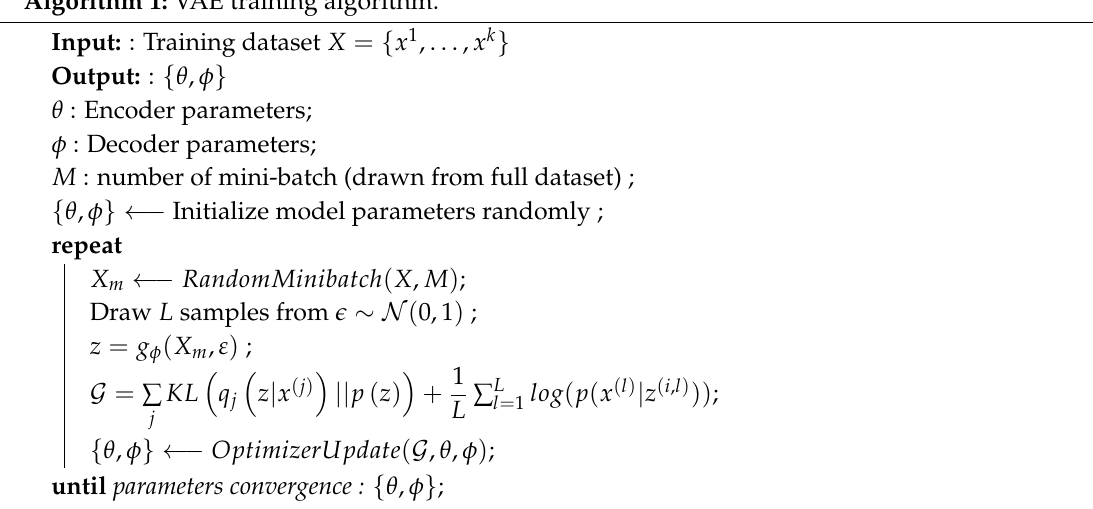
Algorithm 1: VAE training